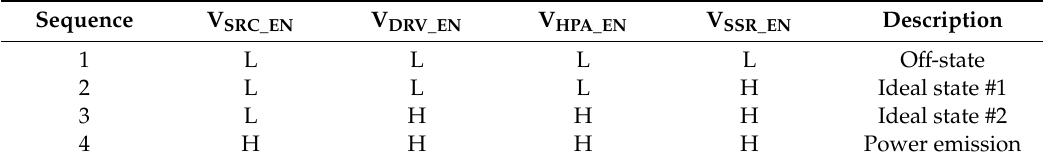
Table 2. The proposed module operating